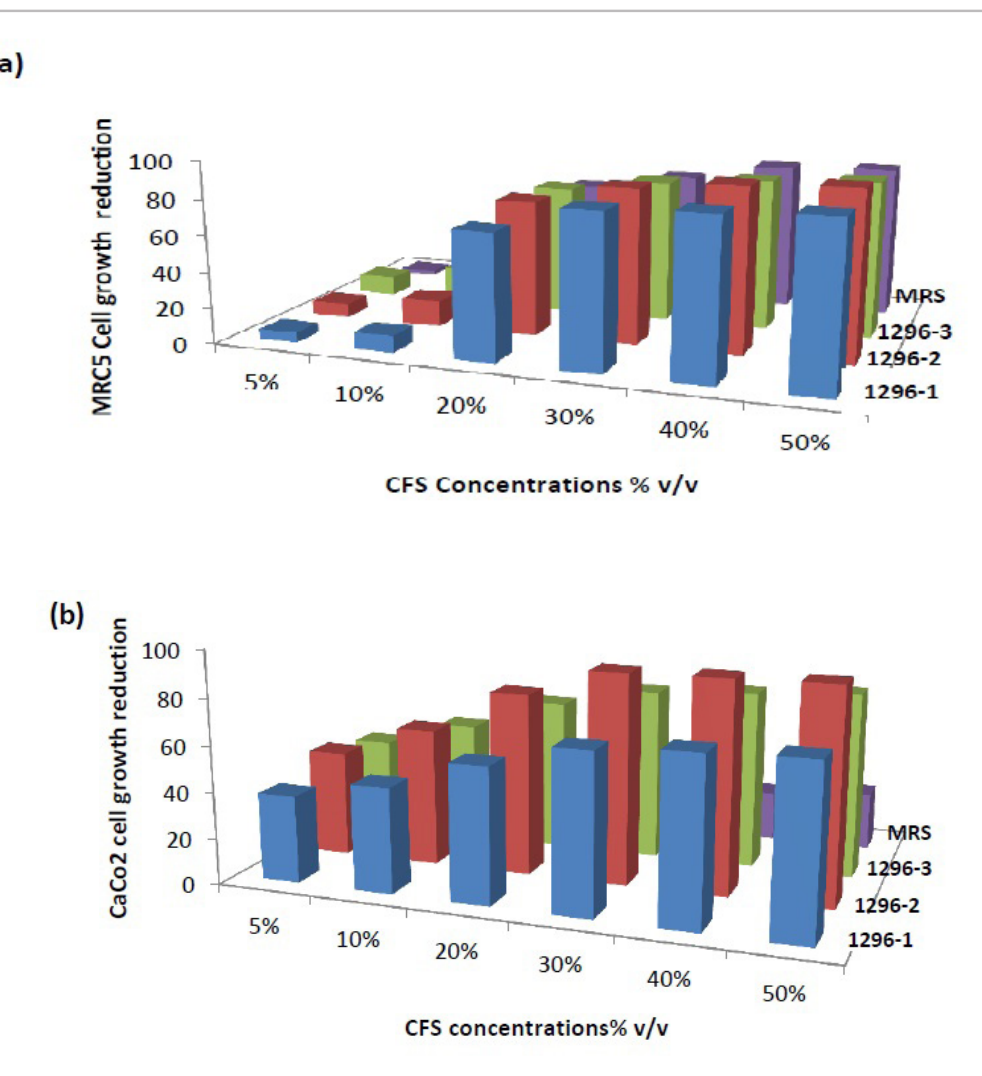
FIGURE 1 - Cell growth inhibition of MRC5 (a) and CaCo 2 (b) cell lines after treatment with different concentrations of cell free supernatant fluids of L.casei RTCC 1296-1, 1296-2 and 1296-3 strains and MRS broth, and determining the number of viable cells after 72 hrs by MTT assay. The results were recorded as mean (SD±) of three individual experiments. CFS: cell free supernatant fluids